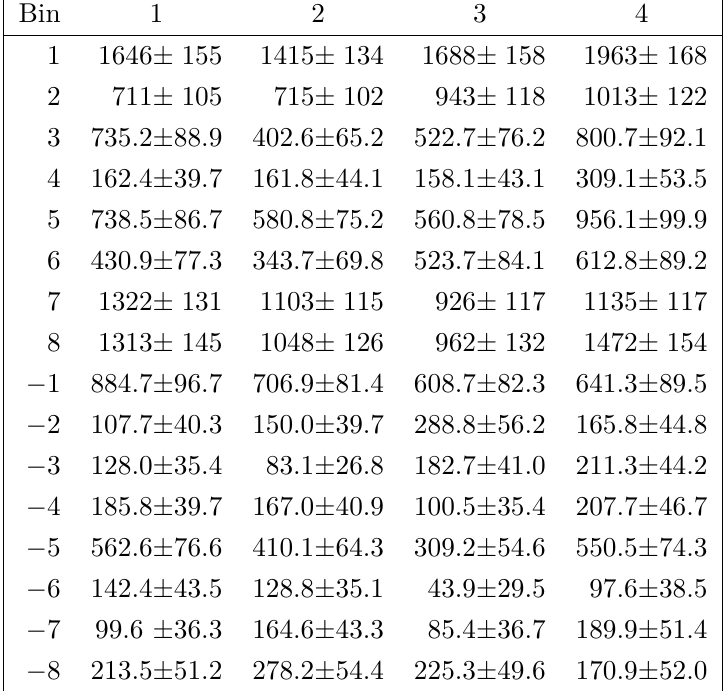
in bin i of D → K 0 π + π − phase space (rows) and i S